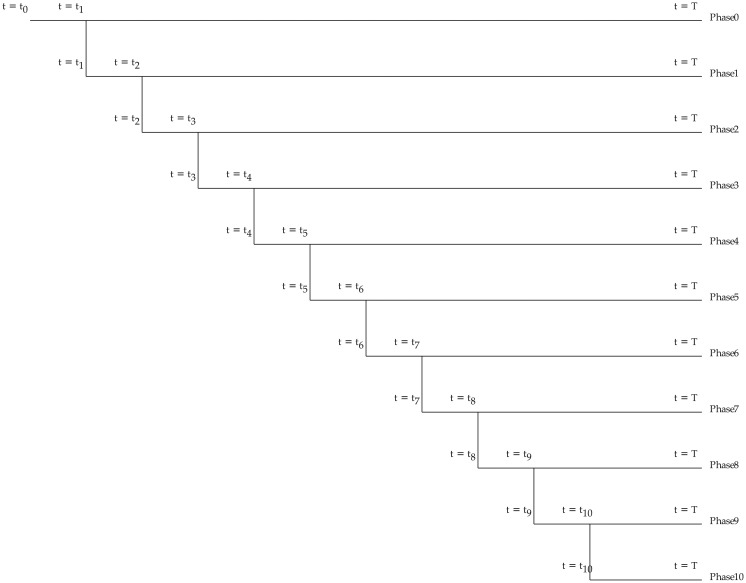
An eleven-phase simulation to study the effect of mutations in the model.Phase 0 starts at t = t0 with 1000 populations, each population containing of 50 cells. In phase k (k = 1, 3, …, 9) the state of the system in t = tk+1, when all of the cells have gone through at least k * 2 divisions, is stored. Phase k + 1 starts at t = tk+1, the time point at which the kth mutation with the probability value of p occurs to the parameters of the cells’ internal switches. All phases finish at t = T.